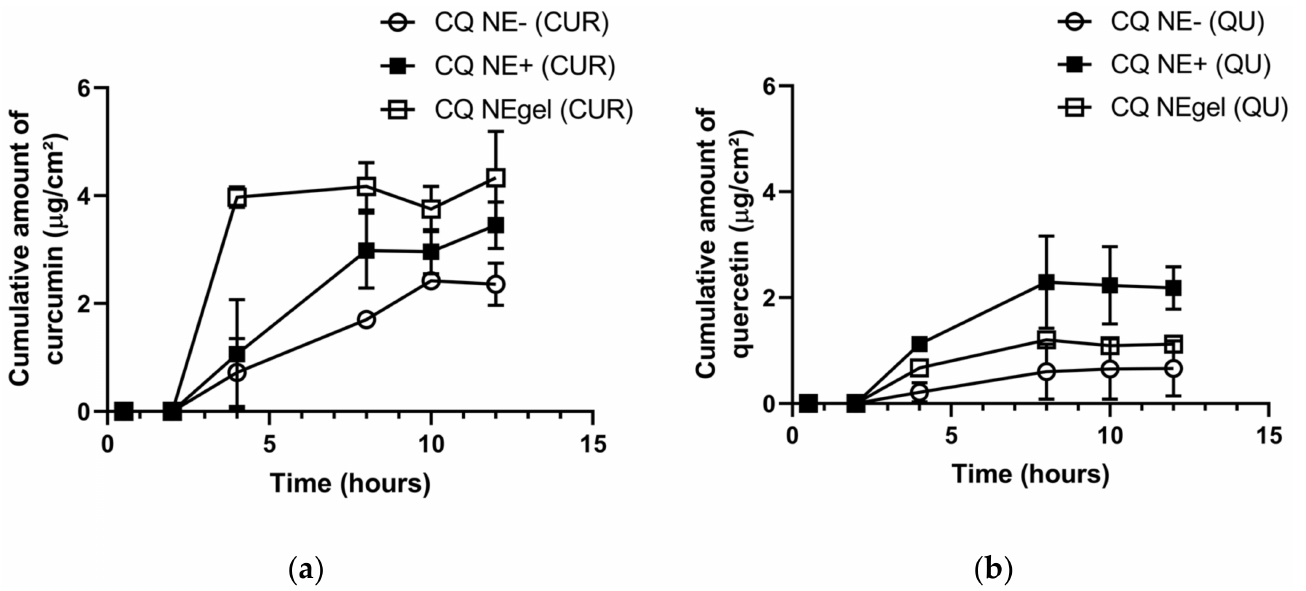
Figure 5. Cumulative amount ( µ g/cm 2 ) of CUR ( a ) and QU ( b ) permeated from CQ NE-, CQ NE+, and CQ NEgel, through porcine nasal mucosa, in polyethylene glycol 400:SNF (20:80, v/v ; pH 6.4) at 37 ◦ C.